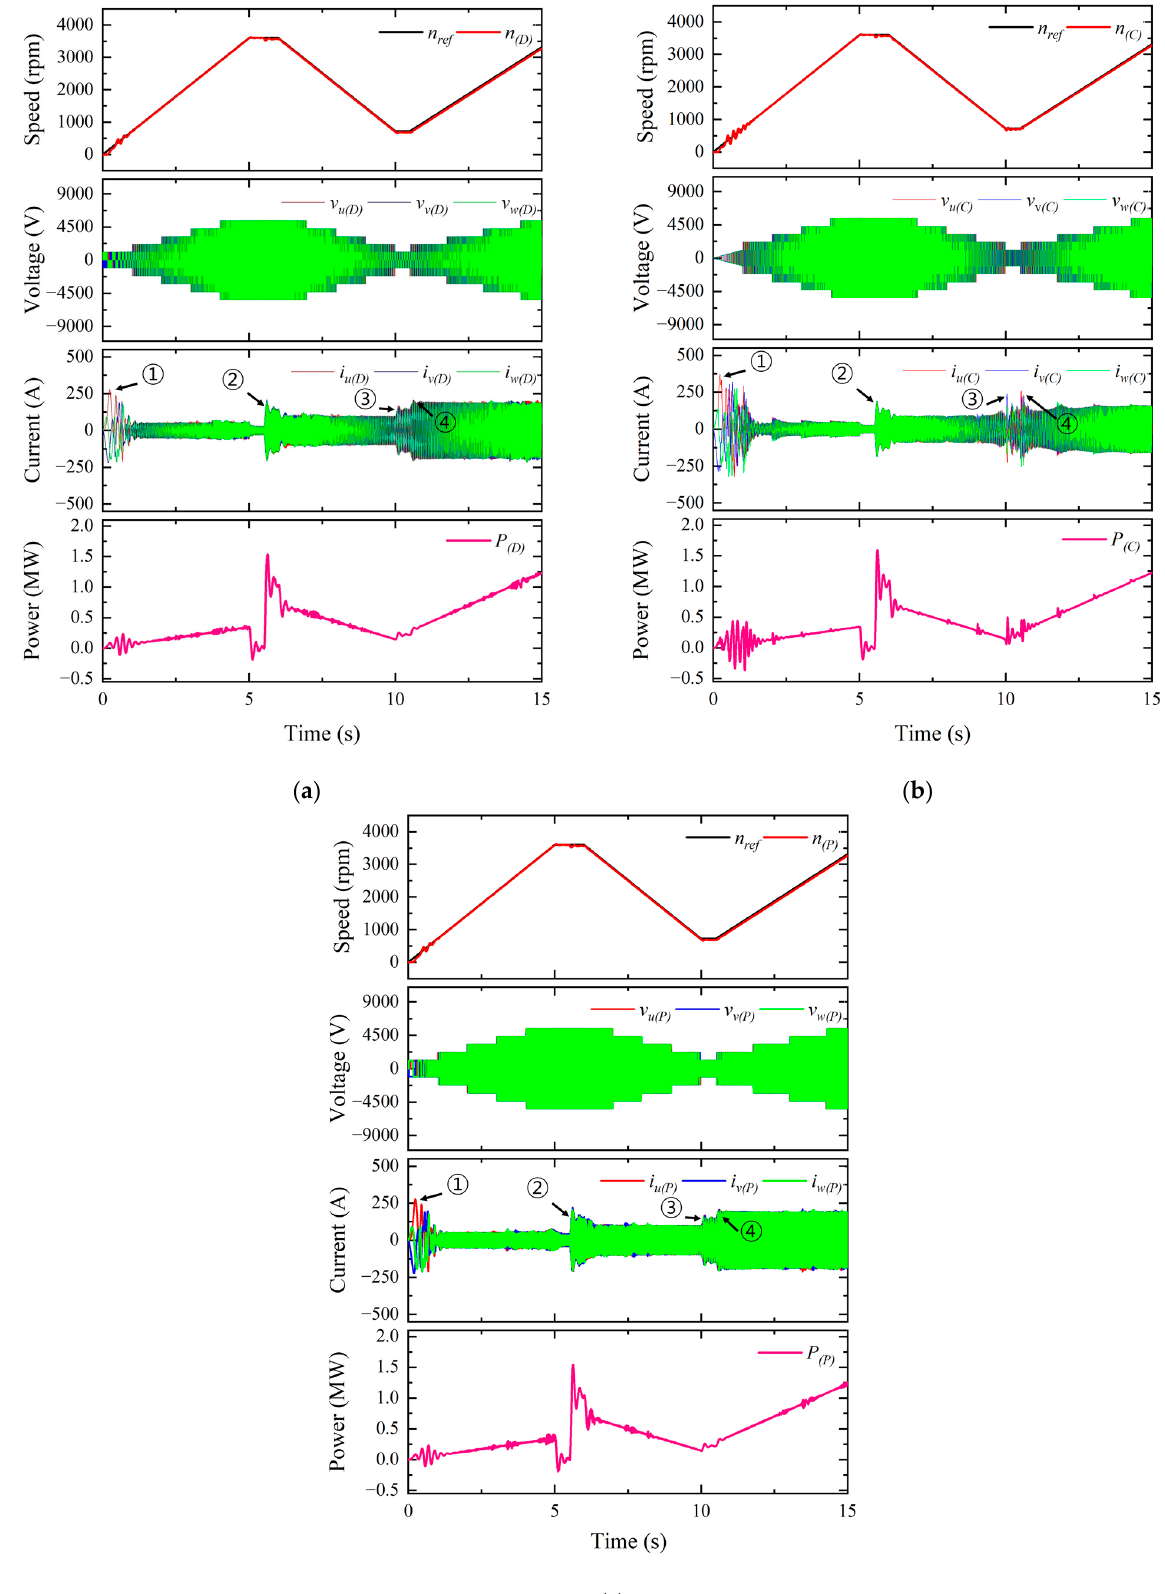
Figure 7. Comparison of dynamic characteristics according to speed variation. ( a ) Detailed model; ( b ) Conventional model; ( c ) Proposed model.